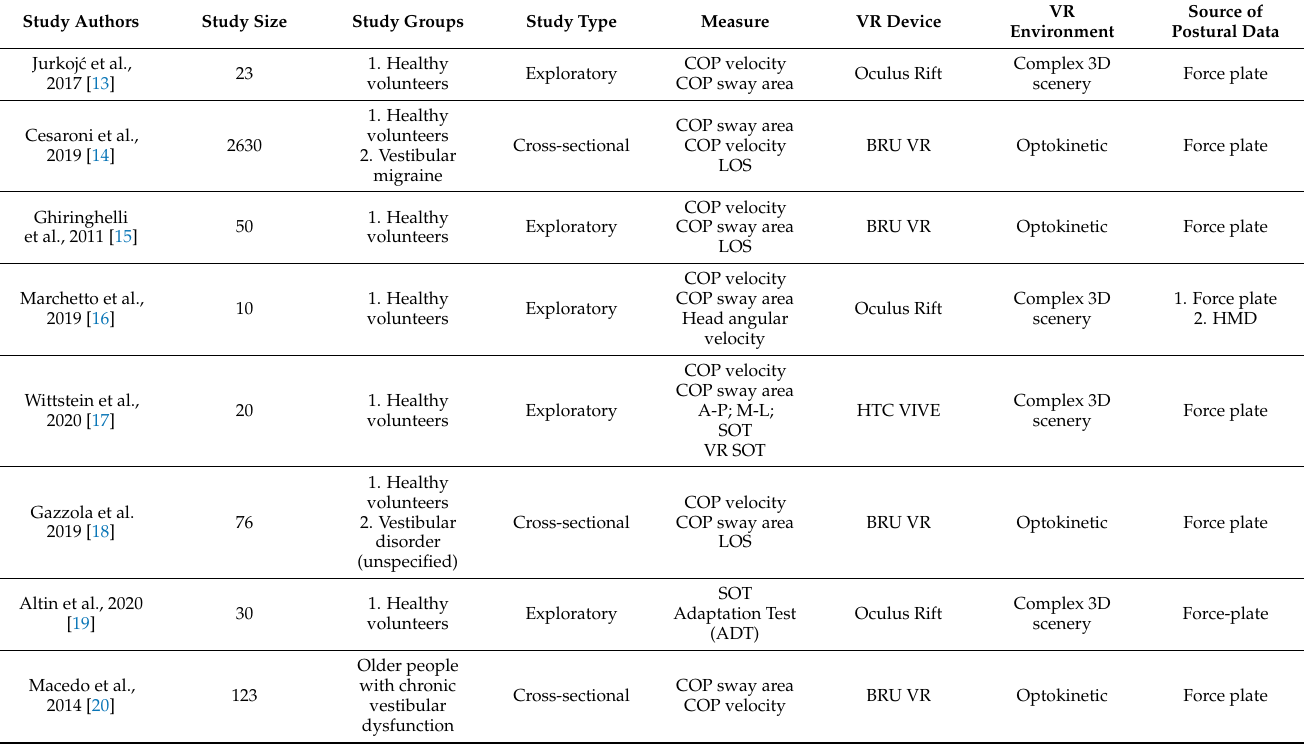
Figure 1. PRISMA 2020 flow diagram for systematic reviews. Table 1. Studies included in this review that explore the application of virtual reality to measurements of posture.